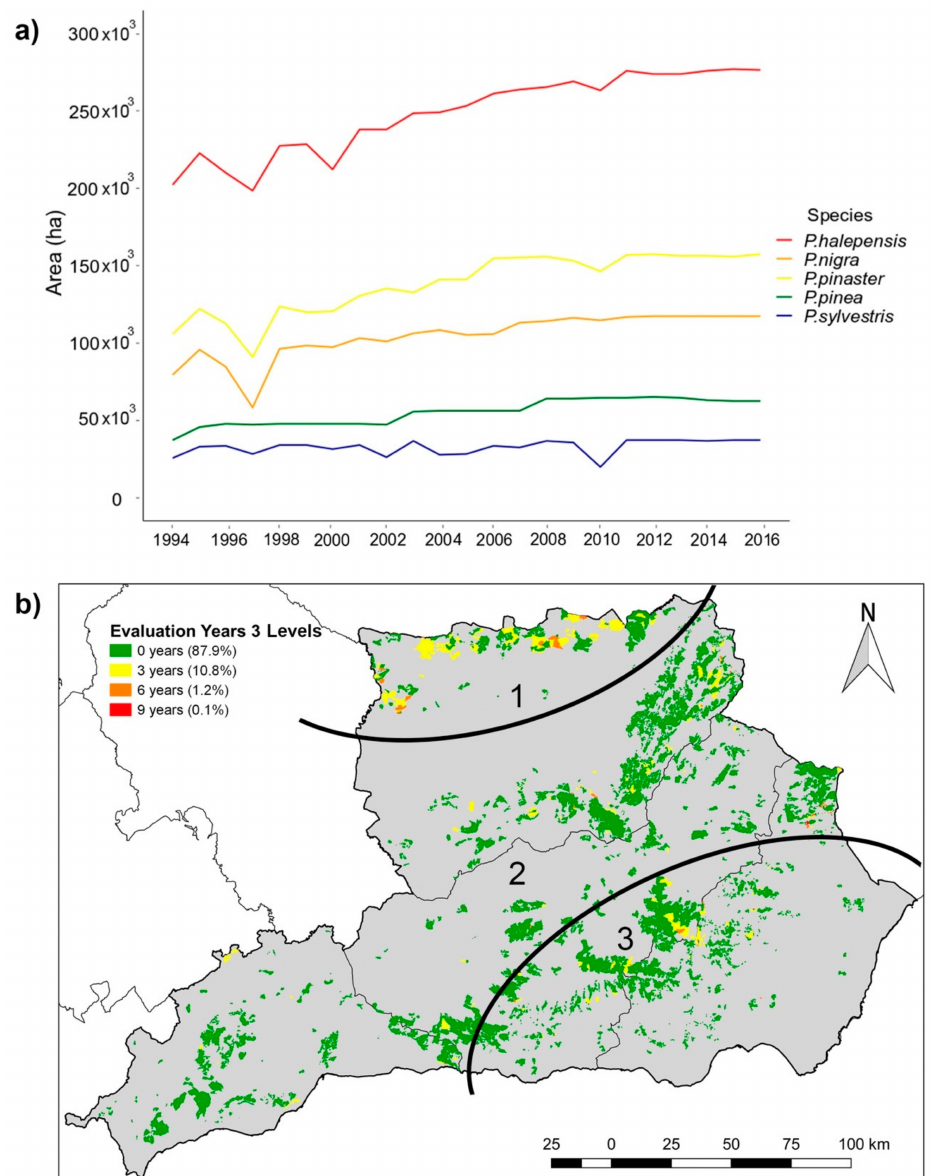
Figure 2. ( a ) Total area of Pinus forests a ff ected by a processionary moth ( Thaumetopoea pityocampa Denis and Schi ff ermüller) in Eastern Andalusia (Spain), ( b ) Map of frequency form moderate to severe PPM defoliation within the Southern Andalusia study area between 1994 and 2016. The key indicates the number of years in which defoliation was recorded on a scale from green (no defoliation) to red (severe defoliation). Three zones of high frequency (northern: 1, central: 2, southern: 3) are separated by two corridors of less frequent